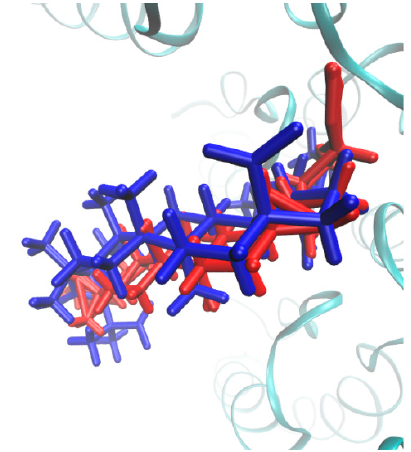
Figure 13. The comparison of the initial (blue) and MD-averaged (red) three-dimensional (3D) geometries of molecule 14a .